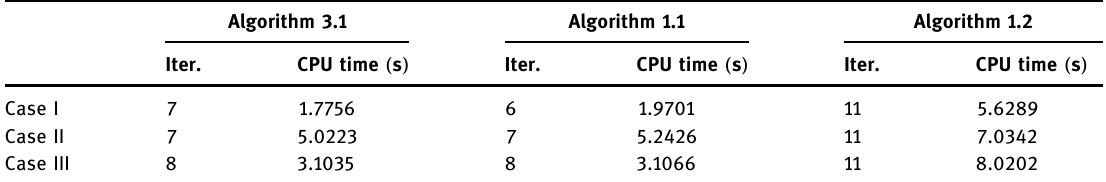
Algorithm 3.1 Algorithm 1.1 Algorithm 1.2